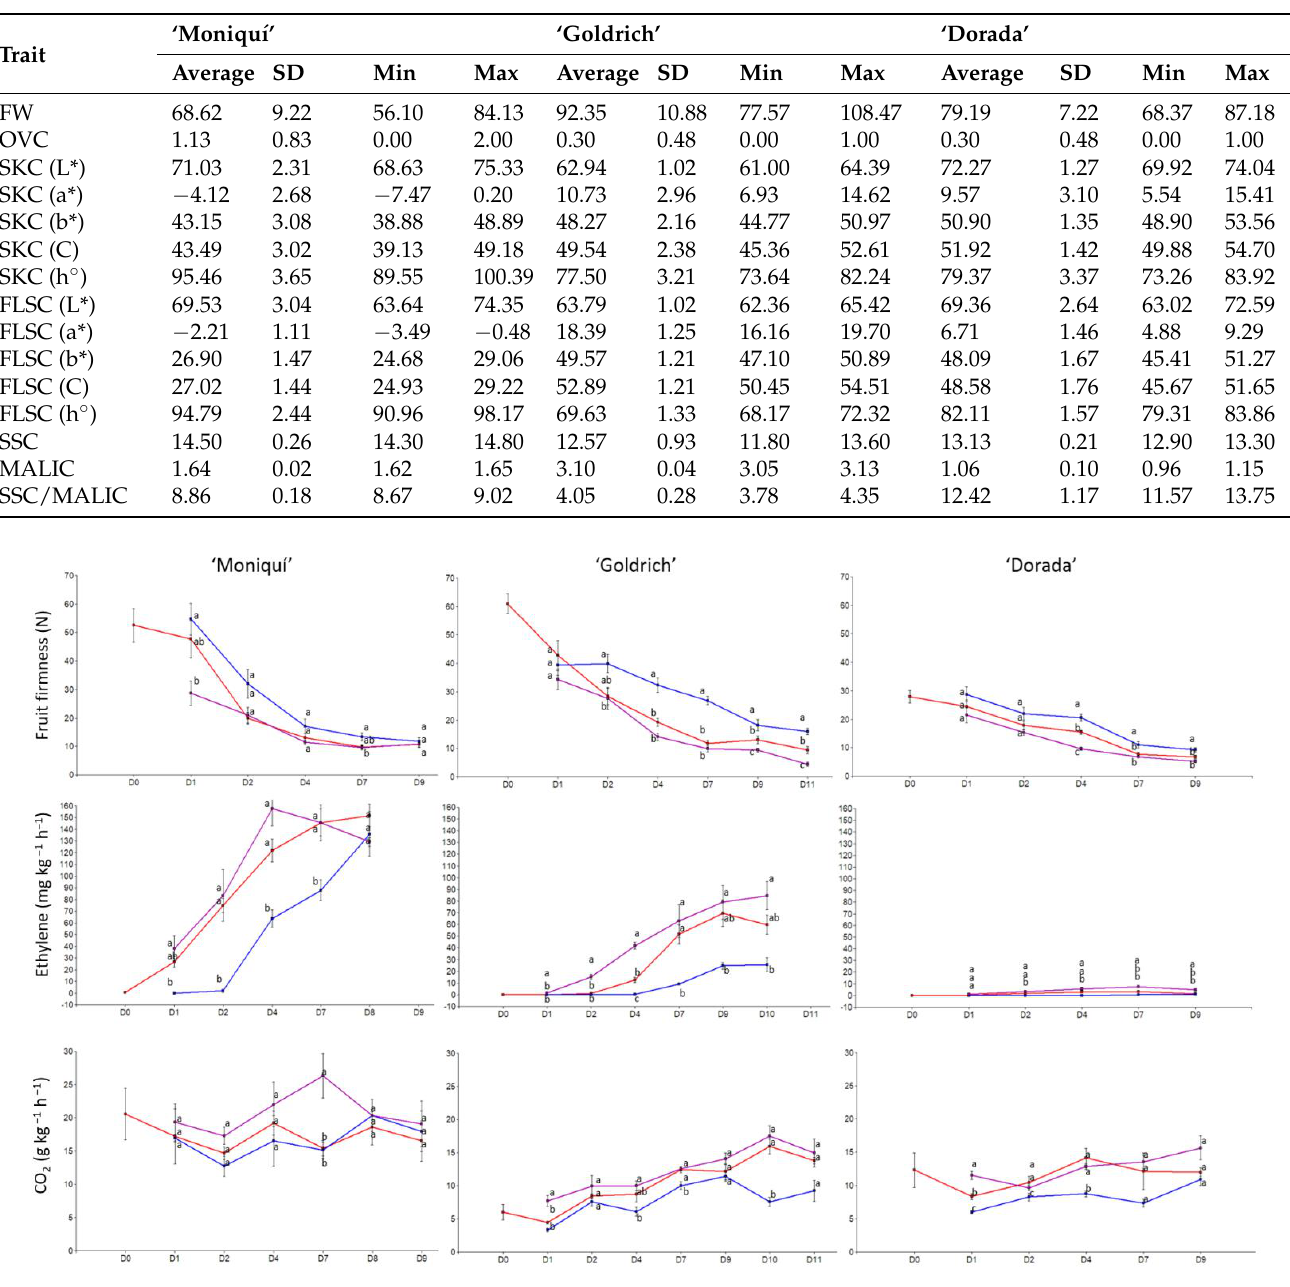
Table 2. Descriptive statistic of fruit quality traits in apricot ( Prunus armeniaca L.) cultivars at harvest time. FW: fruit weight (g); OVC: over color (1 – 4); SKC: skin color (CIE L*, a*, b*, C, and h°); FLSC: flesh color (CIE L*, a*, b*, C, and h°); SSC: soluble solid content (%); MALIC: malic acid content (g